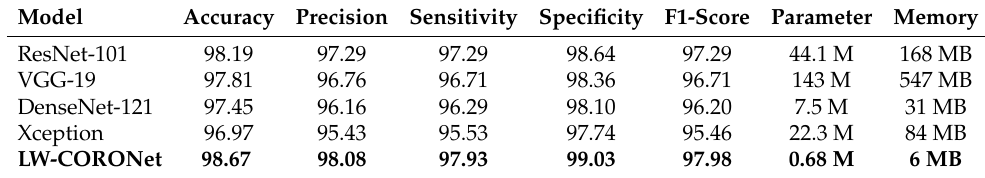
Table 10. Classification performance comparison (in %) among pre-trained CNNs.